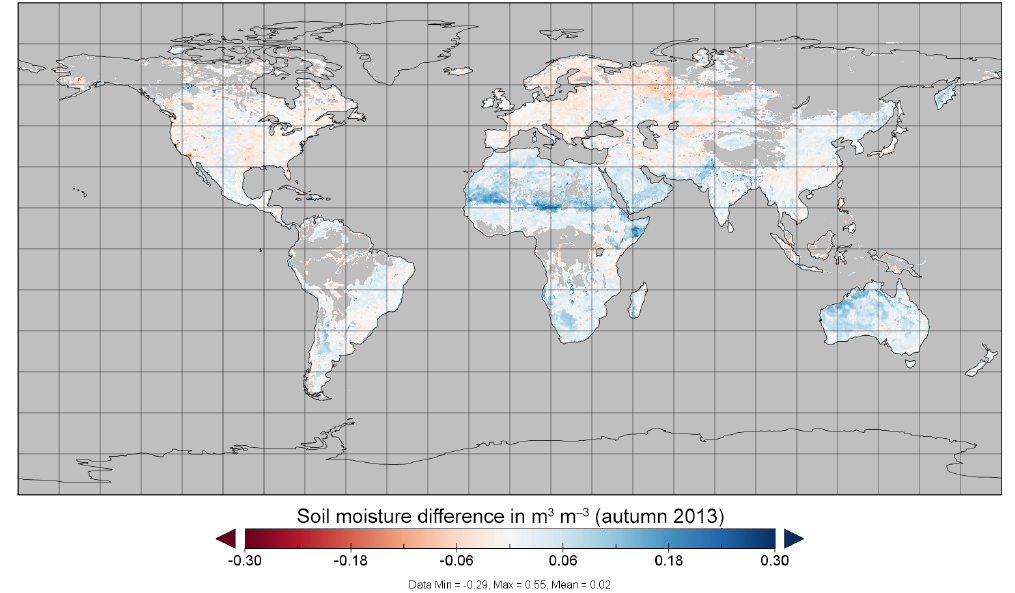
Figure B5. Absolute differences in soil moisture (ESA CCI SM minus CCI NRT) for autumn